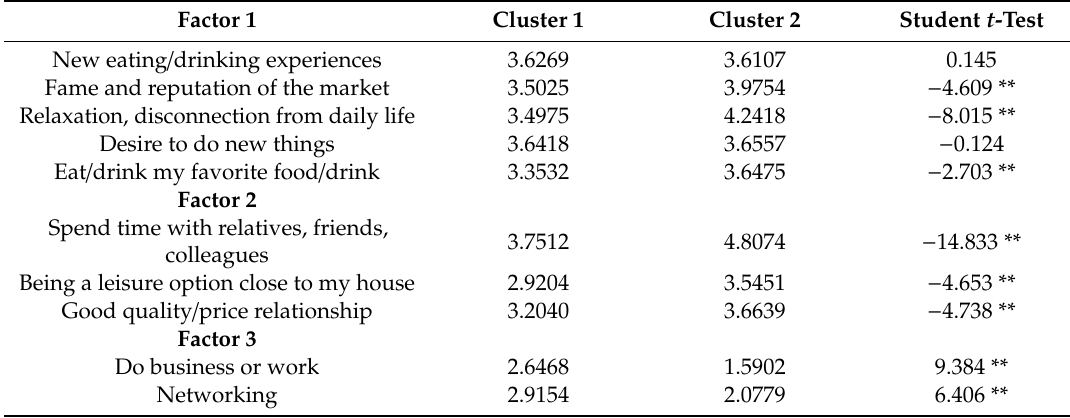
Table 5. Analysis of di ff erences in motivation per cluster.